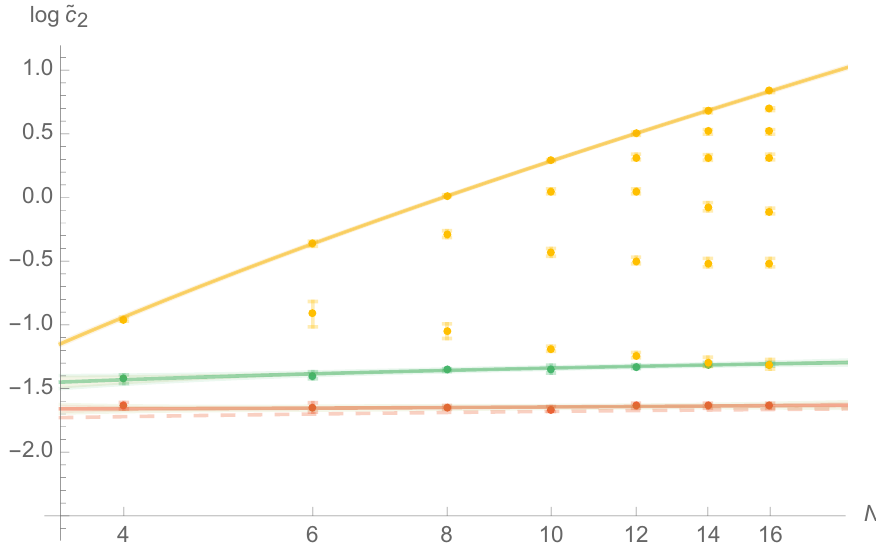
Figure 11 . l→↑↓ transition in the PP model with curvature for c 4 = 0 . 01 , c r = 0 . 01 , 4 ≤ N ≤ 16 e e and fixed ν 2 = ν 4 = 1 , observed as peaks in χ and M . The green/center data represents the correct choice of scaling ν r = 0 , the orange/top ∆ ν r = +1 , the red/bottom ∆ ν r = − 1 and the pale-red dashed line the PP model. For ∆ ν r = +1 and fixed N , magnetization peaks N/ 2 − 1 times (unconnected orange dots) with increasing c 2 until χ reaches its maximum and eigenvalue e distribution splits in two, causing the phase transition (connected orange dots). Errorbars are mostly covered by data markers and pale-coloured stripes represent the 68% confidence intervals.